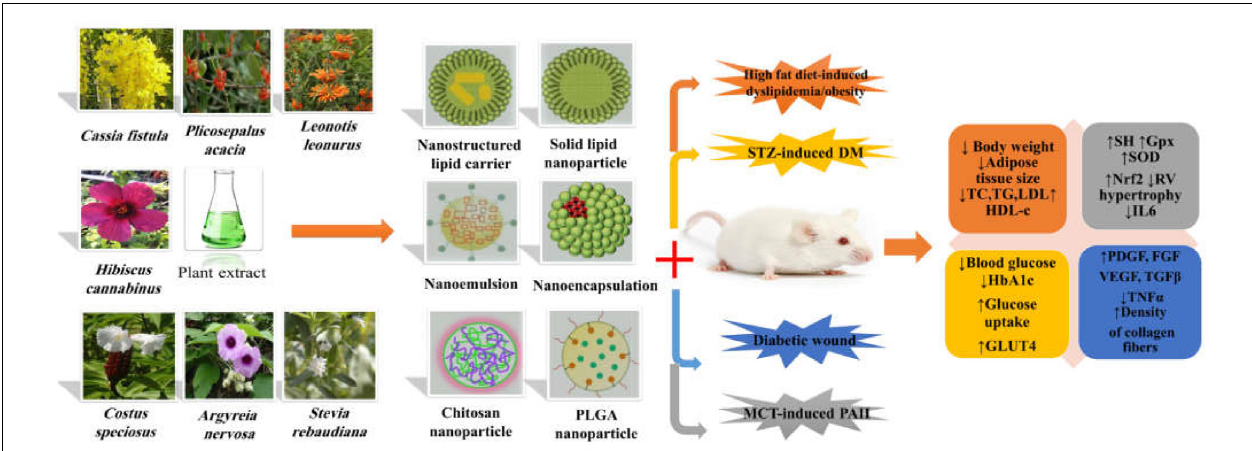
FIGURE 3 | The role of extract-loaded nano-delivery systems in management of metabolic syndrome and its complications. STZ, streptozotocin; MCT, monocrotaline; PAH, pulmonary arterial hypertension; TC, total cholesterol; TAG, triacylglycerol; LDL-C, low-density lipoprotein-cholestrol; VLDL, very-low-density lipoprotein; HDL-C, high-density lipoprotein; SH, sulfhydryl group; GPx, glutathione peroxidase; SOD, superoxide dismutase; Nrf2, nuclear factor erythroid 2–related factor 2; RV, right ventricular; IL-6, interleukin 6; PDGF, platelet-derived growth factor; FGF, fibroblast growth factors; VEGF, vascular endothelial growth factor; TGF β , transforming growth factor β ; TNF α , tumor necrosis factor; GLUT4, glucose transporter type 4; HbA1c, hemoglobin A1c; PLGA poly lactic-co-glycolic